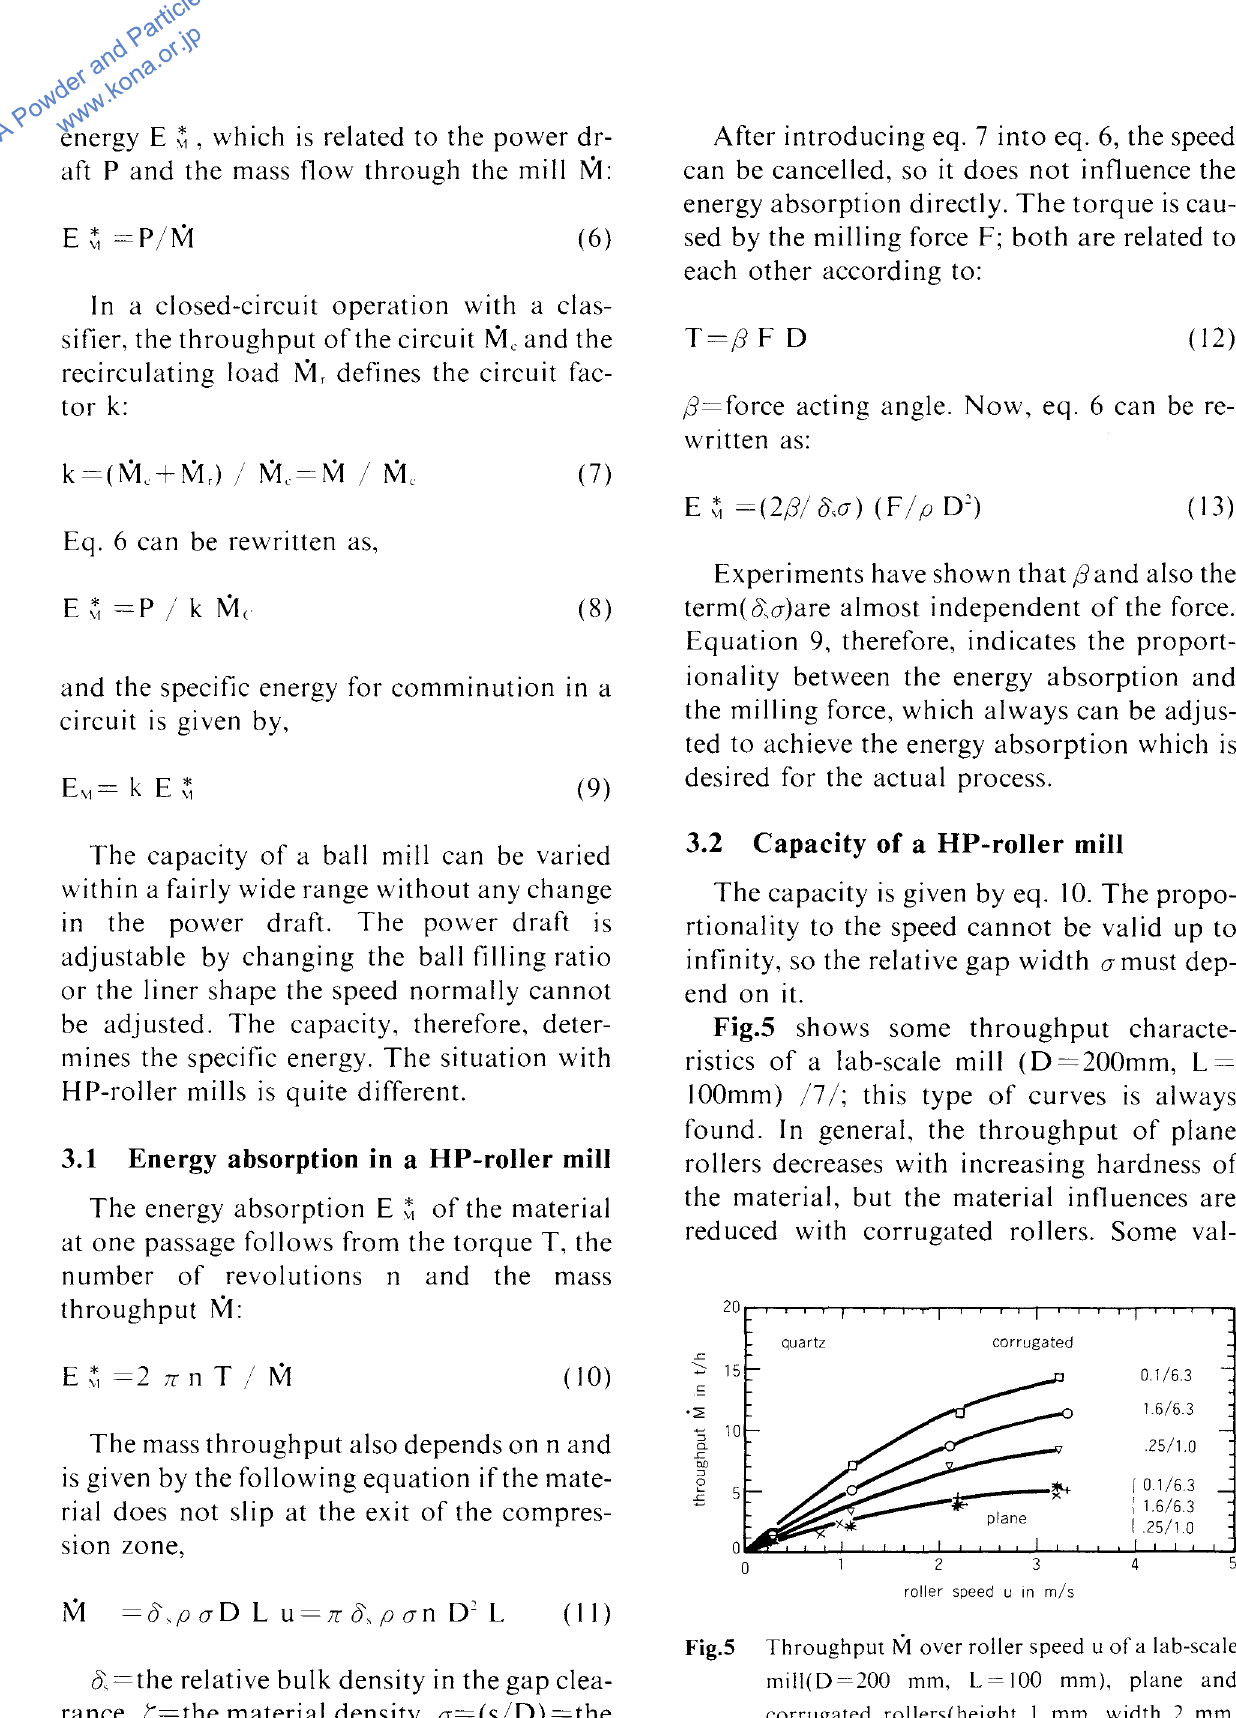
Fig.S Throughput M over roller speed u of a lab-scale mill(D=200 mm, L= 100 mm), plane and corrugated rollers(height I mm, width 2 mm, distance 6 mm}, quartz feed 0.25/ 1.00. 1.6/6.3, 0.1/6.3